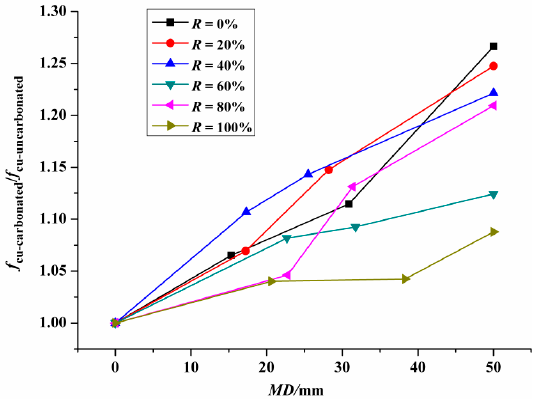
Figure 5. Relative cubic compressive strength of RAC versus the MD.